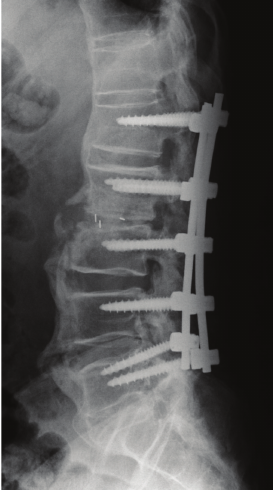
Figure 3: Lateral plain X-ray image obtained after the first surgery. In addition to posterior fusion at the L1–L5 intervertebral space, posterior lumbar interbody fusion at the L2-L3 intervertebral space was performed using a PEEK cage and local bone.